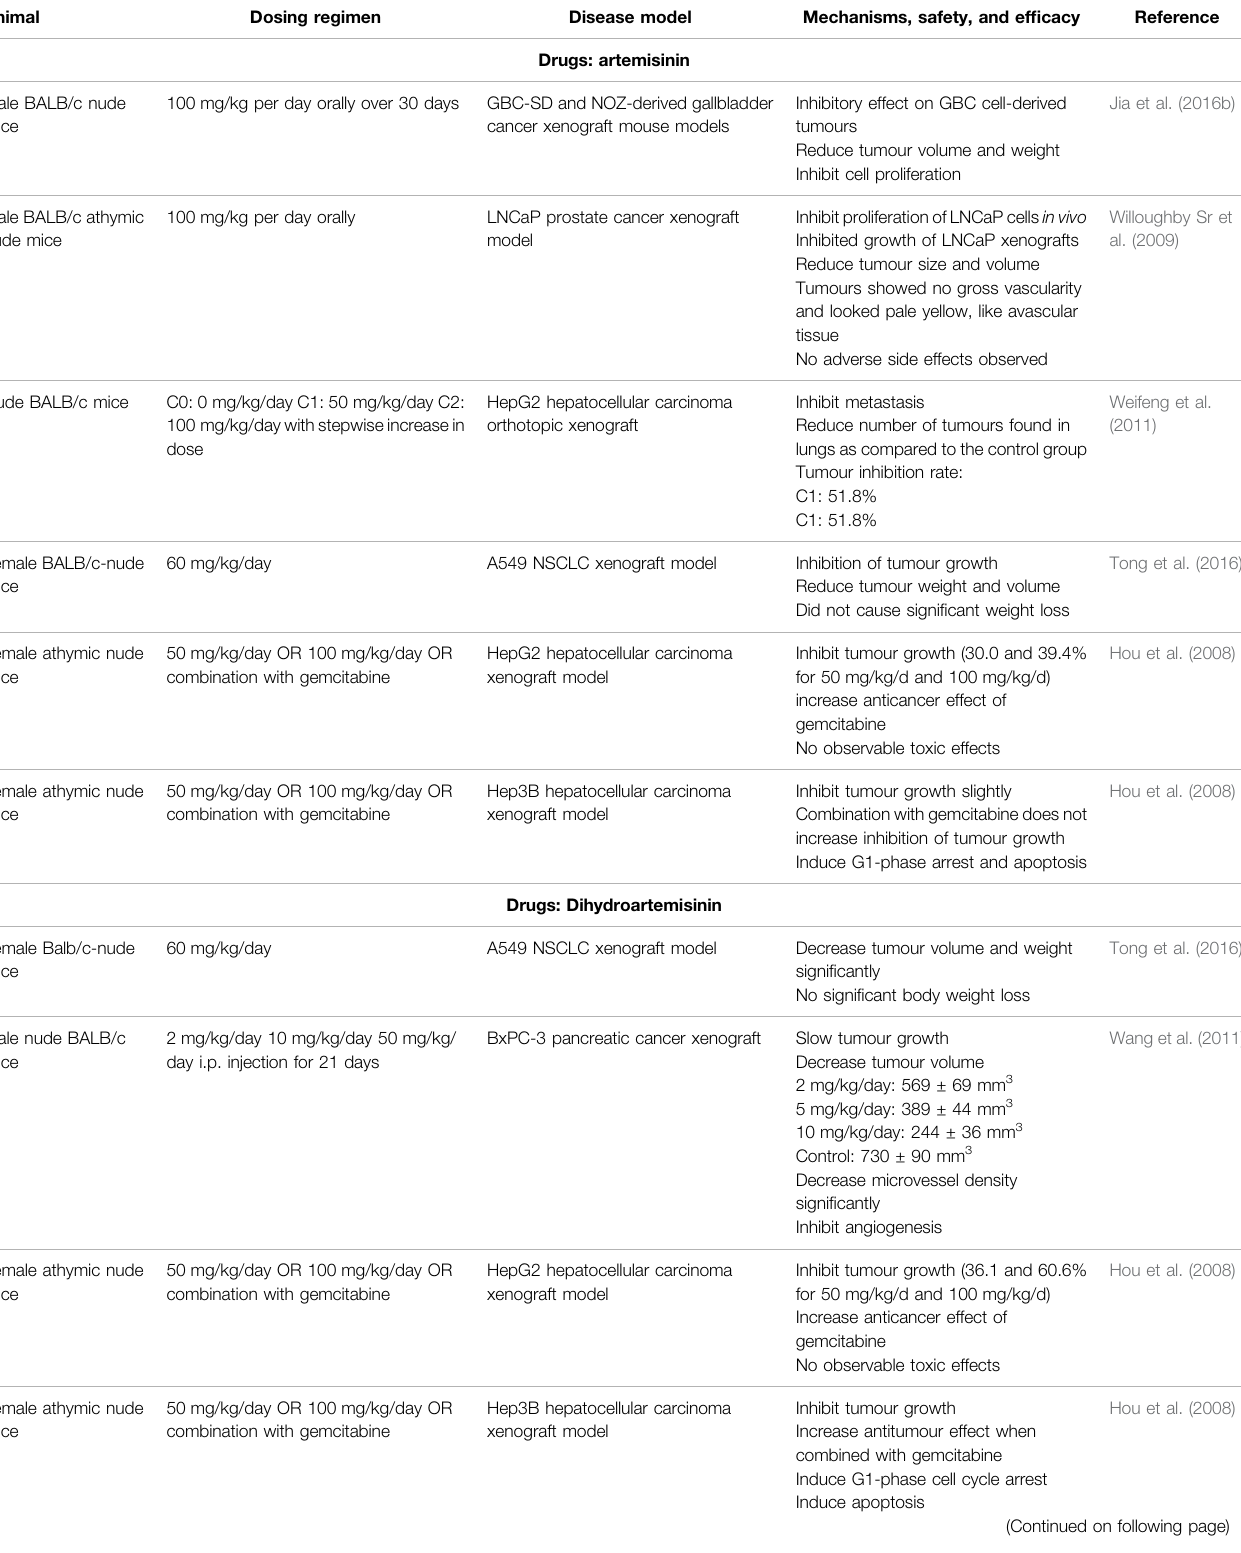
TABLE 2 | Dose and Mechanisms of Action of artemisinins in vivo